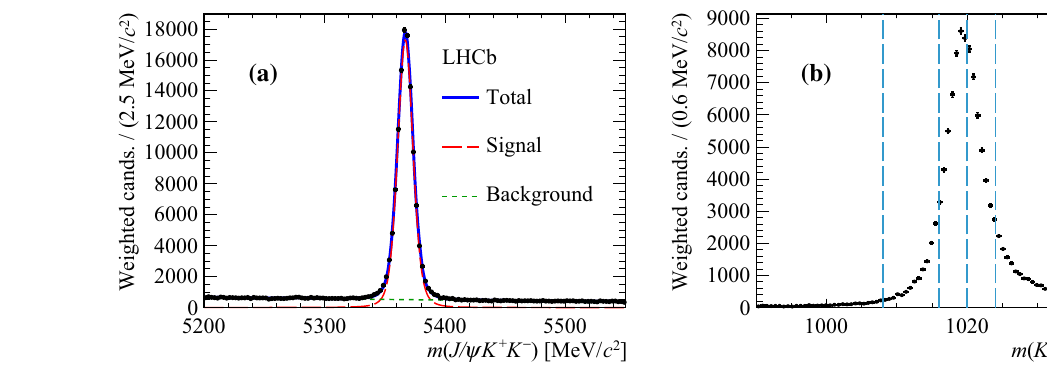
Fig. 2 a Distribution of the invariant mass of selected B 0 s → J /ψ K + K − decays. The signal component is shown by the long-dashed red line, the background component by the dashed green line and the total fit function by the solid blue line. The background contribution → J /ψ pK − decays is statistically subtracted. The contri- due to Λ 0 b